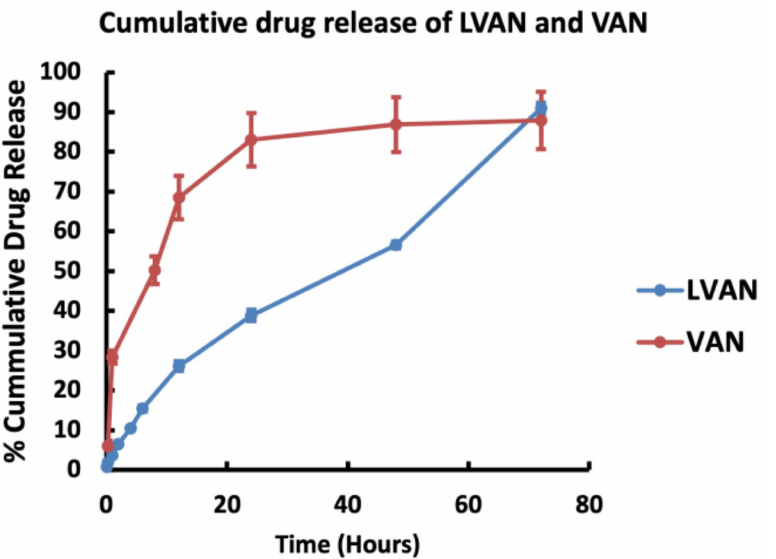
Figure 4. Comparative cumulative drug release profile of LVAN over 72 h shows a controlled VAN release